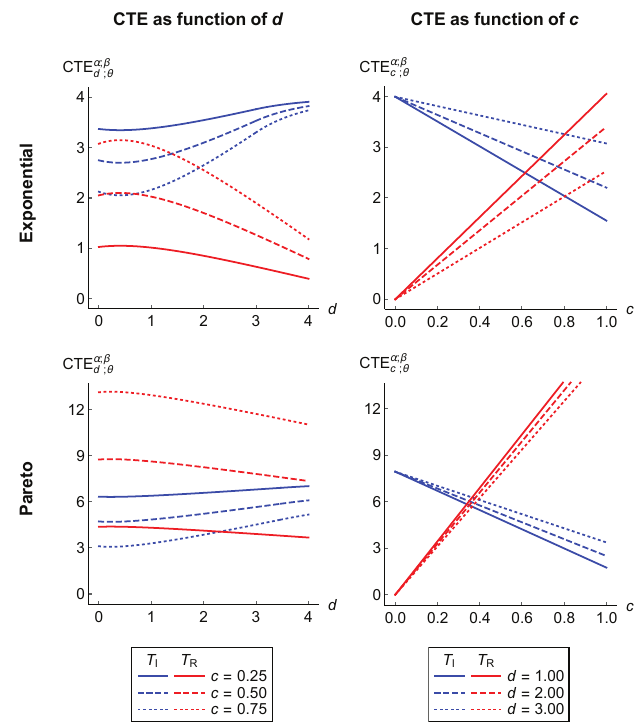
( T ) and CTE α R ; β ( T ) as functions of d only (on the left side) and Figure 3. The curves of CTE α I ; β I R d , c ; θ d , c ; θ as functions of c only (on the right side) in the presence of the combined stop-loss and quota-share reinsurance. They are determined at α I = 0.05, α R = 0.01, and β = 0.20 when the initial loss X follows E ( 1 ) (on the upper side) or P ( 2 ) (on the lower side).